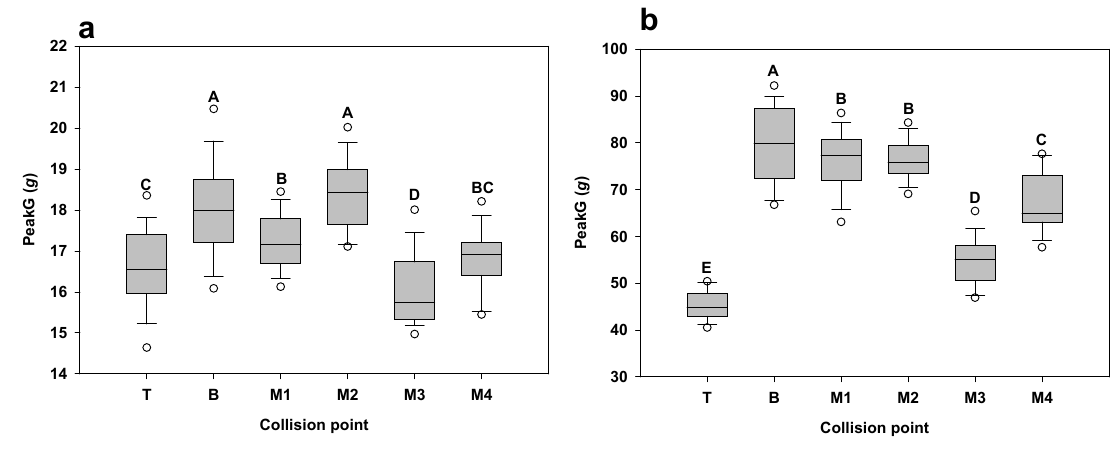
Figure 15. Uniformity test results for padding sheet ( a ) and steel ( b ). The collision points with the same letter indicate that there was no significant difference between